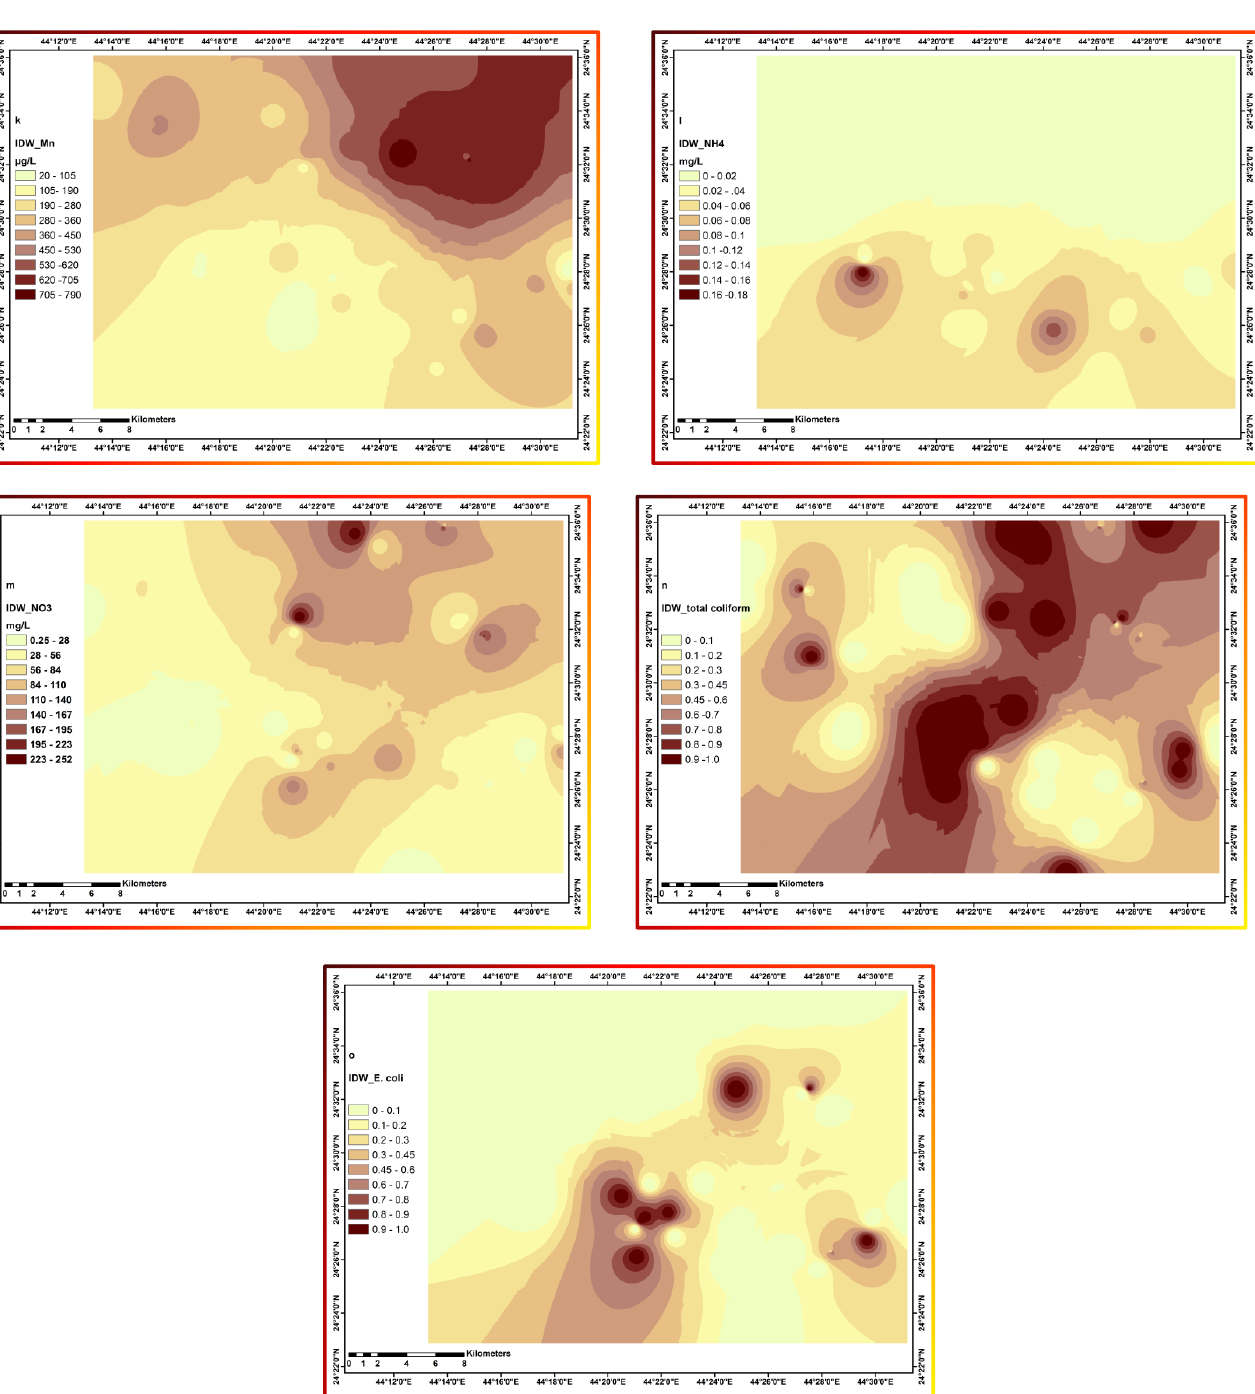
Figure 3. Spatial distribution maps portraying spatial variability of the concerned parameters throughout the study area. The sub-graphs represent the SD distribution of individual parameters; ( a ): temperature; ( b ): pH; ( c ): dissolved organic carbon; ( d ): dissolved oxygen; ( e ): total dissolved solids; ( f ): well-depth; ( g ): Copper; ( h ): Cobalt; ( i ): Lead; ( j ): iron; ( k ): Manganese; ( l ): ammonium; ( m ): nitrate; ( n ): total coliform; and ( o ): E. coli .